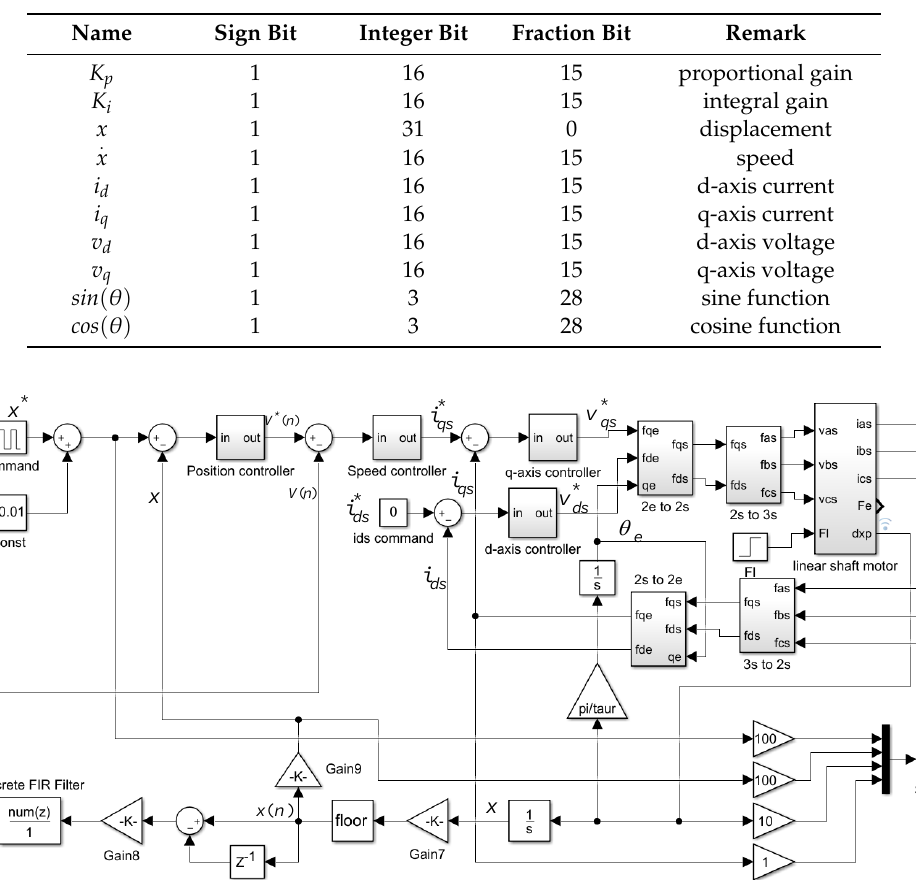
Table 2. The data format of the variables and the parameters of the designed controllers.